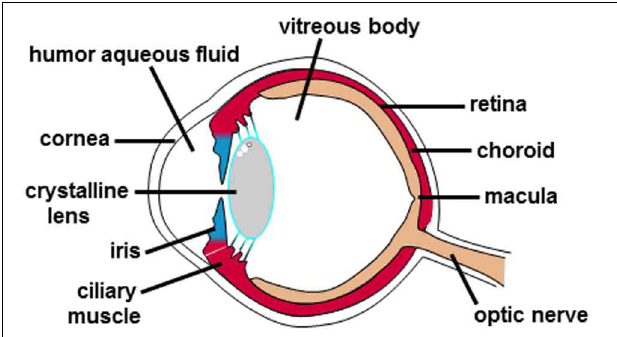
FIGURE 1 | Anatomical structure of the human eye. The different anatomical entities of the human eye are indicated.